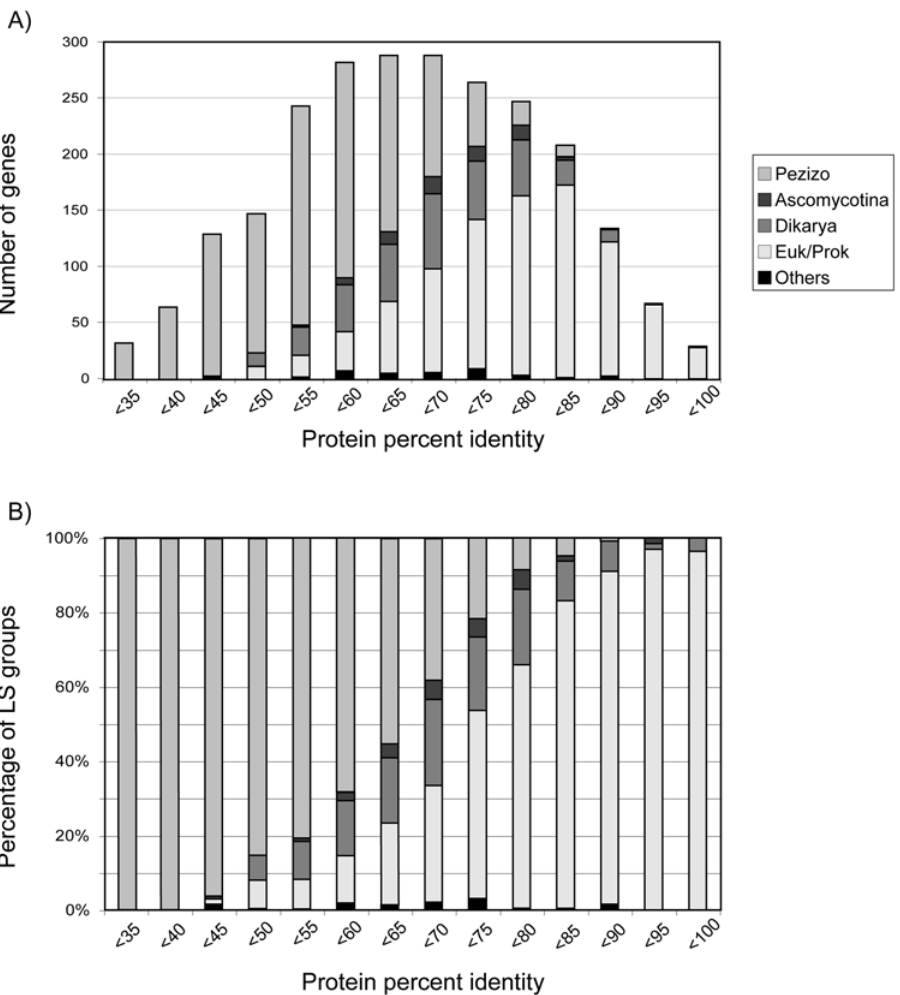
Figure 3. Histograms showing the relationship of percent protein identity scores between N.crassa and C.globosum and the number (A) and percentage (B) of protein coding genes (PCGs) in each of the lineage specificity (LS) groups. Note that the Pezizo-specific group is larger in the bins of lower protein percent identity as compared to the Euk/Prok-core genes, which is significantly higher in the bins of high protein identity.